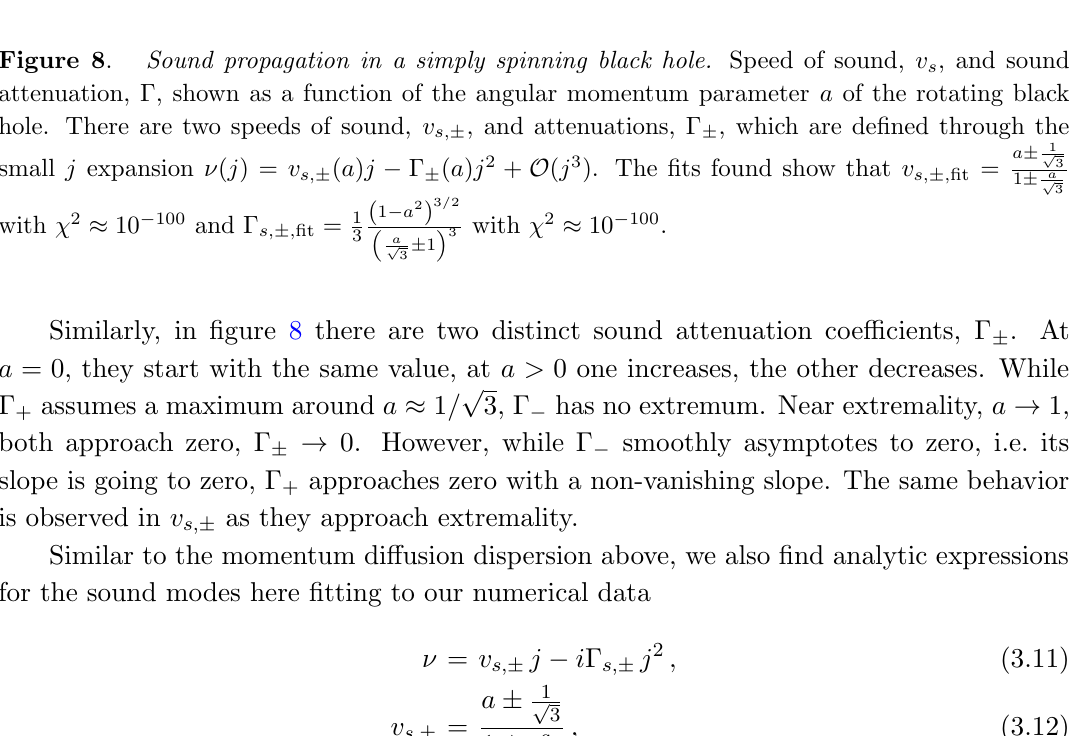
a (cid:6) 1 p 3 1 (cid:6) a p 3